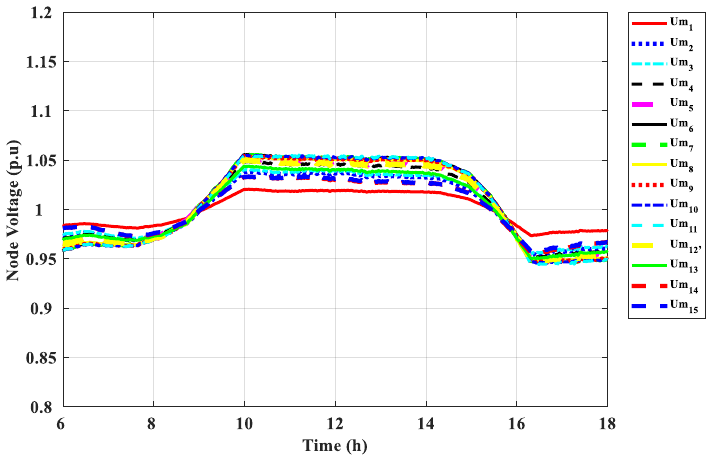
Figure 10. The voltage of the PV nodes with voltage control. Figure 11 shows that when the voltage is about to exceed the limit, due to the control law (8) and (23), the PV inverter will choose to compensate or absorb reactive power based on the actual situation of each node, and its compensation or absorption capacity matches the maximum reactive capacity. The ratio Q / C is shown in Figure 12. The Q / C ratios of each PV are nearly equal from 6:00 to 18:00. We thus conclude that the control strategy in this paper is effective.